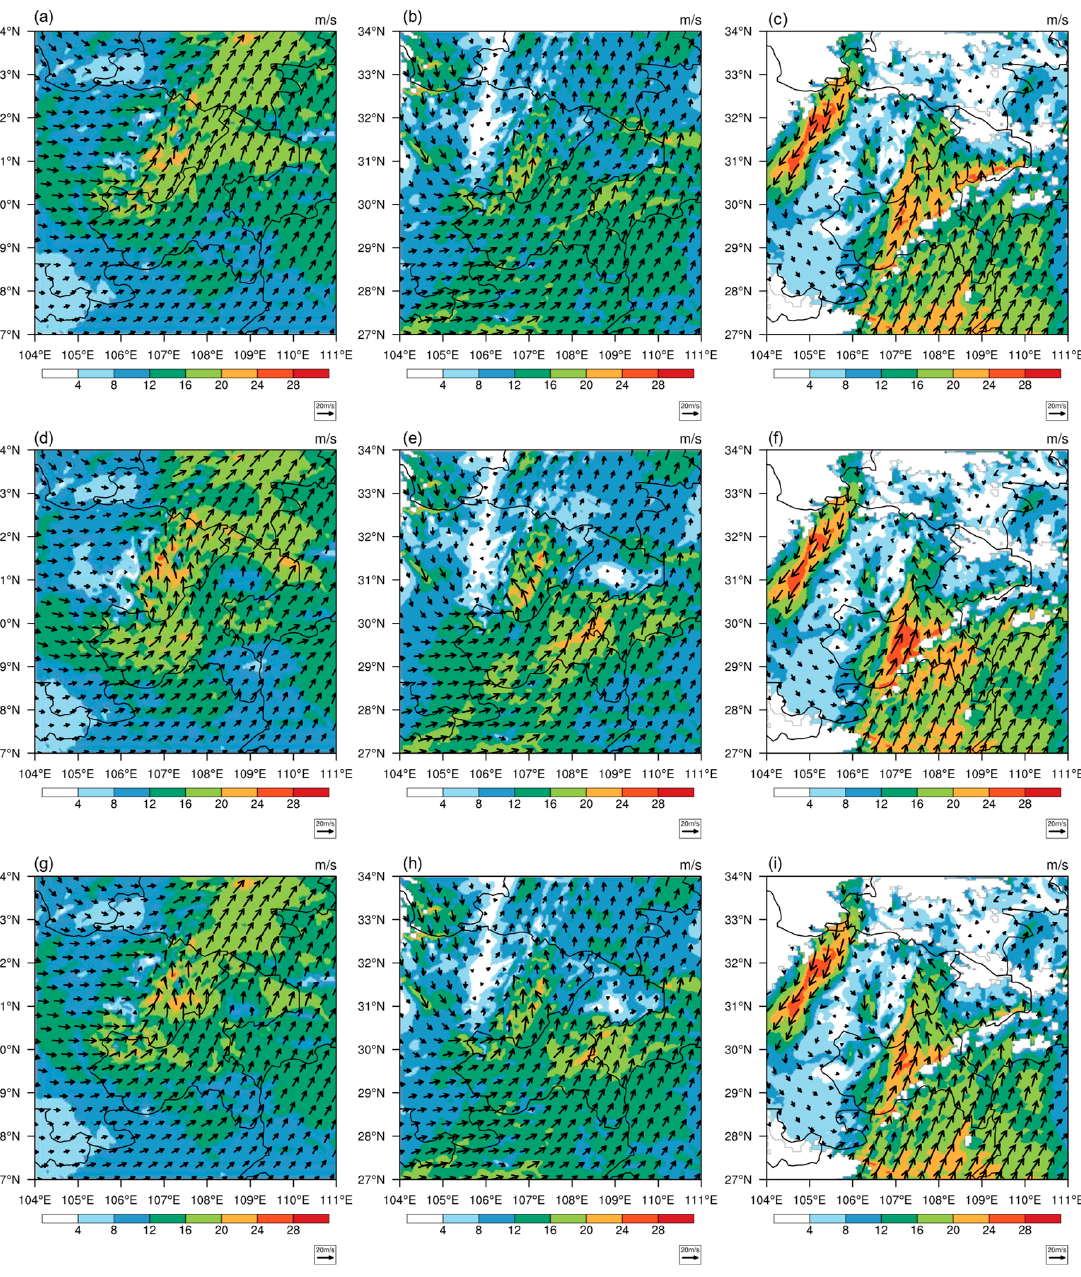
Figure 5. ( a–c ) background and ( ψ−χ : d–f ; U − V: g–i ) analysis wind speed (shaded; units: m s − 1 ) and Figure 5. ( a – c ) background and ( ψ − χ : d – f ; U − V: g – i ) analysis wind speed (shaded; units: m s − 1 ) wind vector at 500, 700, 850 hPa at 2100 UTC 4 June. and wind vector at 500, 700, 850 hPa at 2100 UTC 4